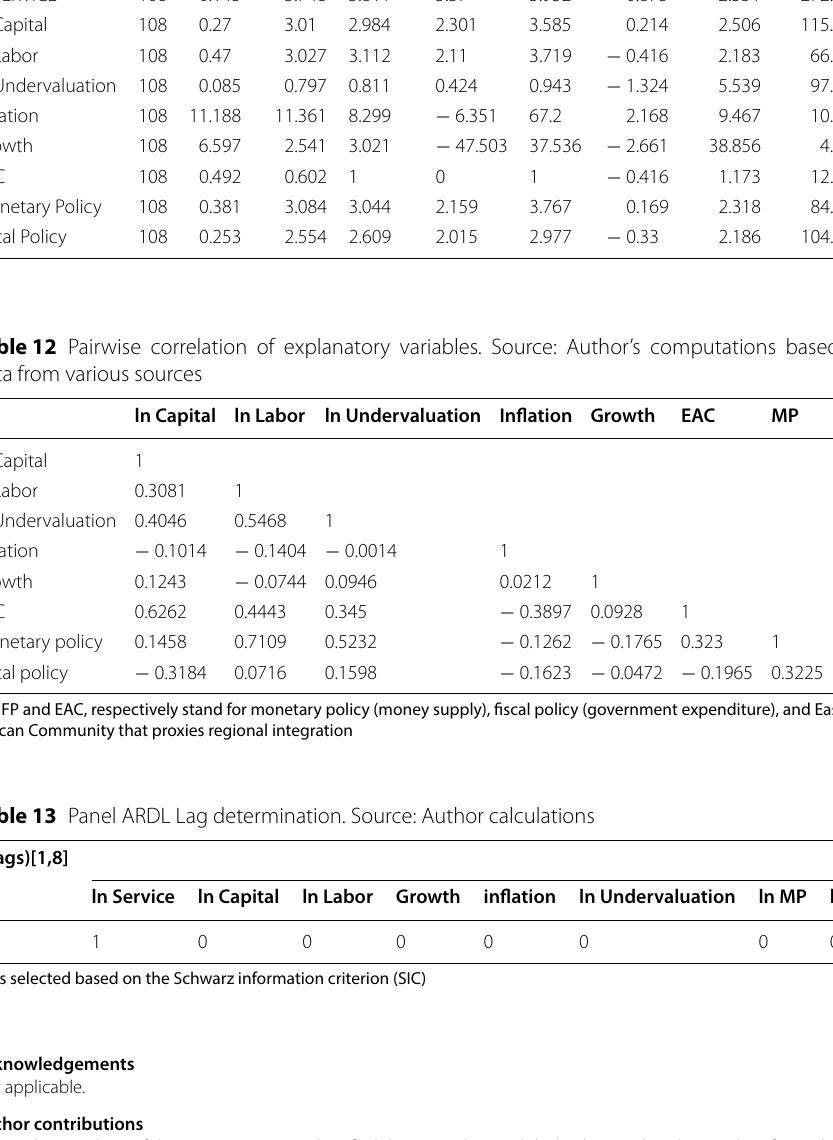
Lags selected based on the Schwarz information criterion (SIC)